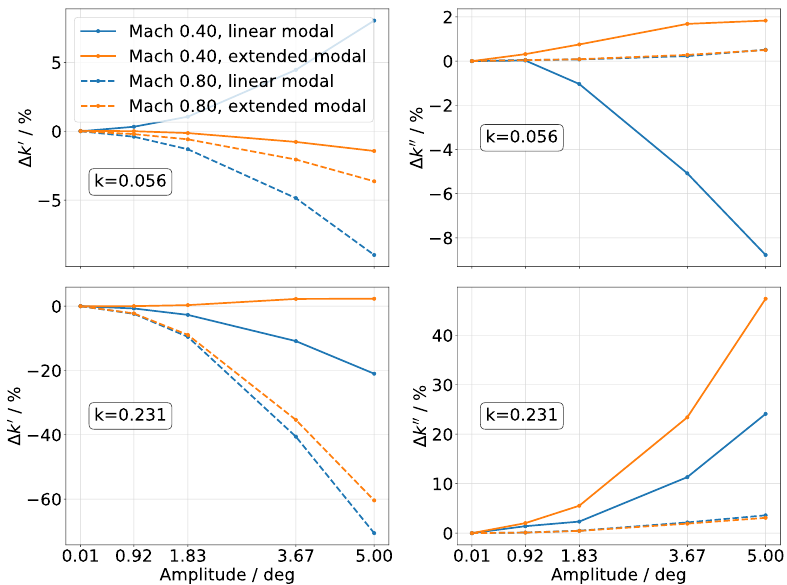
Figure 15. Impact of fluid compressibility on aerodynamic stiffness and damping of Q hh ( 2,1 ) (Viscous flow)